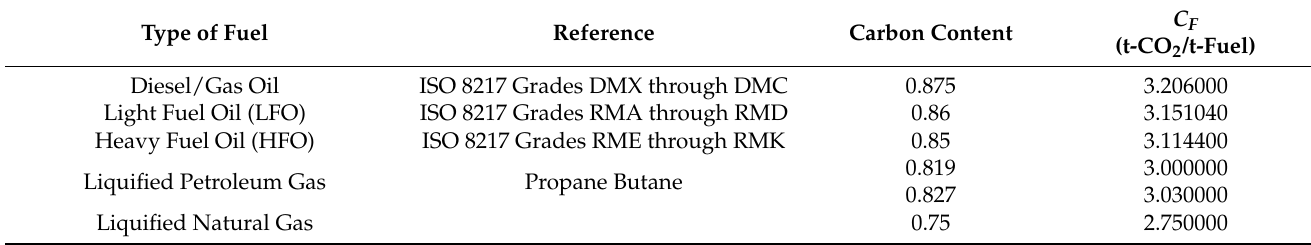
Table 6. CO 2 emission factor according to the